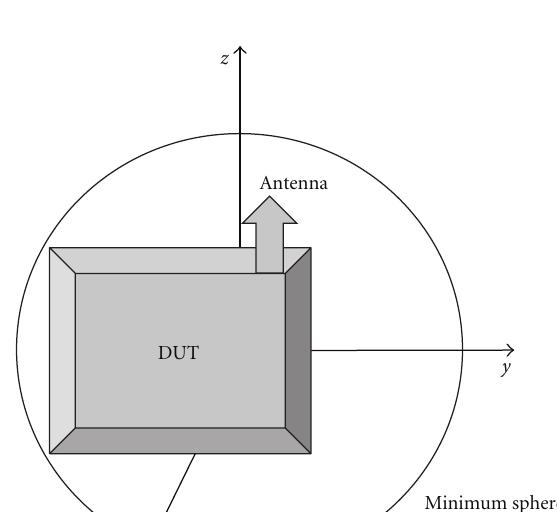
Figure 1: Spherical coordinates.